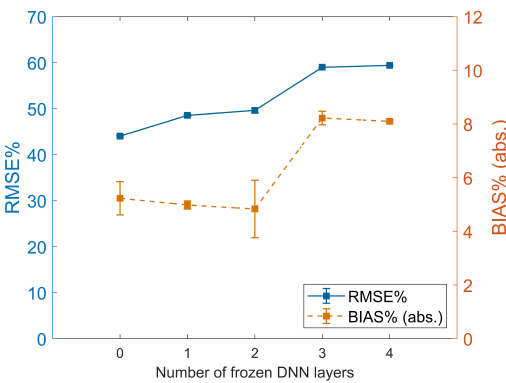
Figure 8. Test set average relative root-mean-squared error (RMSE%) and average of relative bias absolute values (BIAS% abs.) for transfer learning models with 0–4 hidden layer weights frozen. The whiskers show the 99% confidence intervals from 100 modeling iterations (not visible for RMSE%).